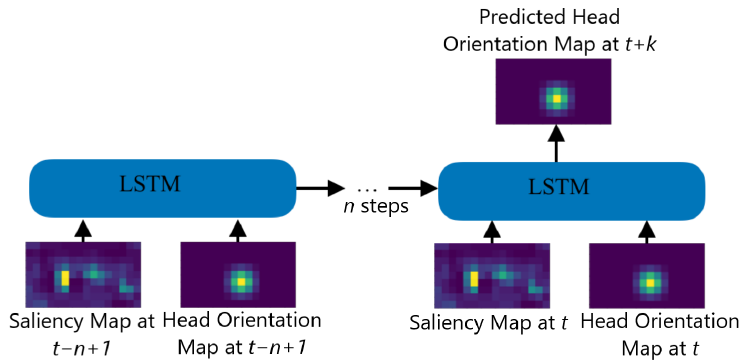
Figure 3. The proposed LSTM